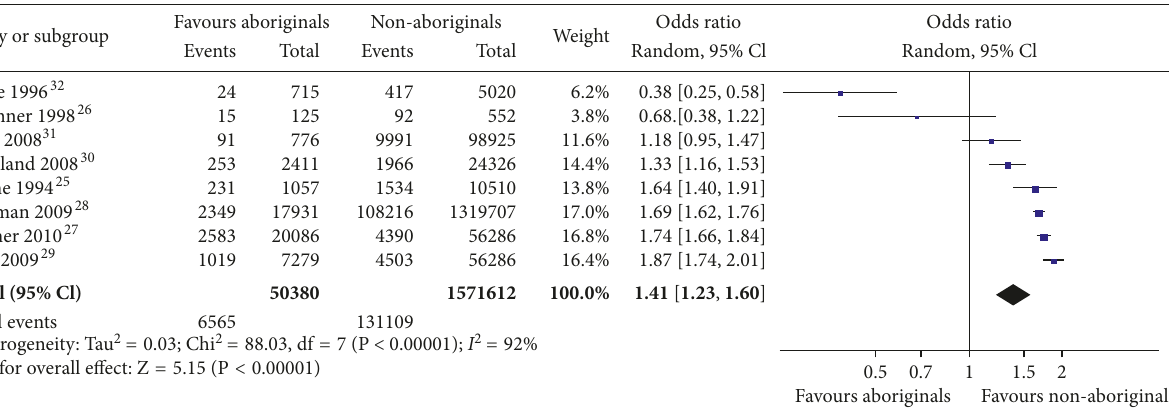
Figure 3: Meta-analysis of the comparison of asthma prevalence between Aboriginals and